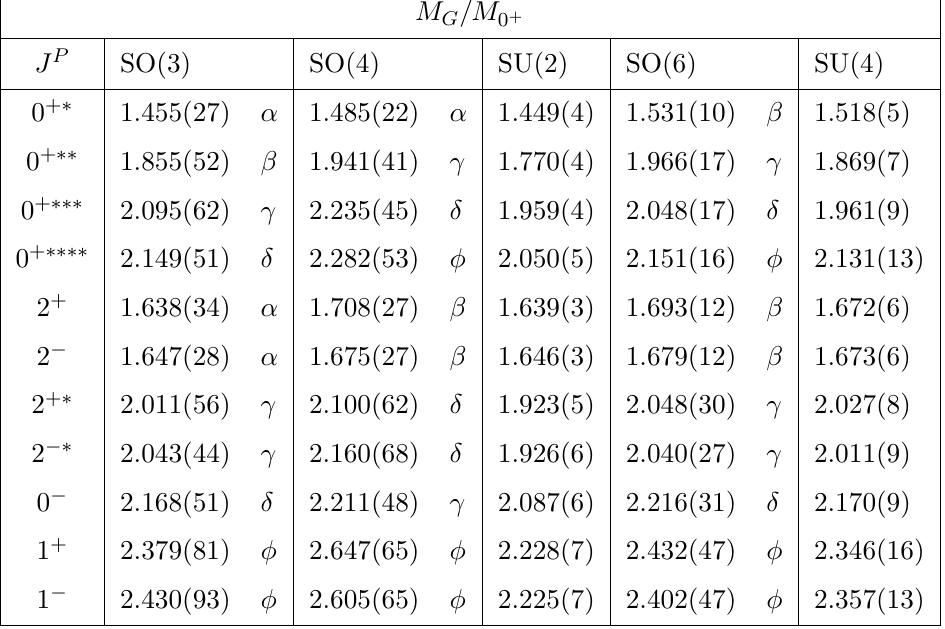
Table 33 . Continuum glueball massesin units of the mass gap: comparing the spectra of SO( N ) gauge theories with those of SU( N 0 ) with the same Lie algebra. Grades, e.g. (cid:11) , explained in section